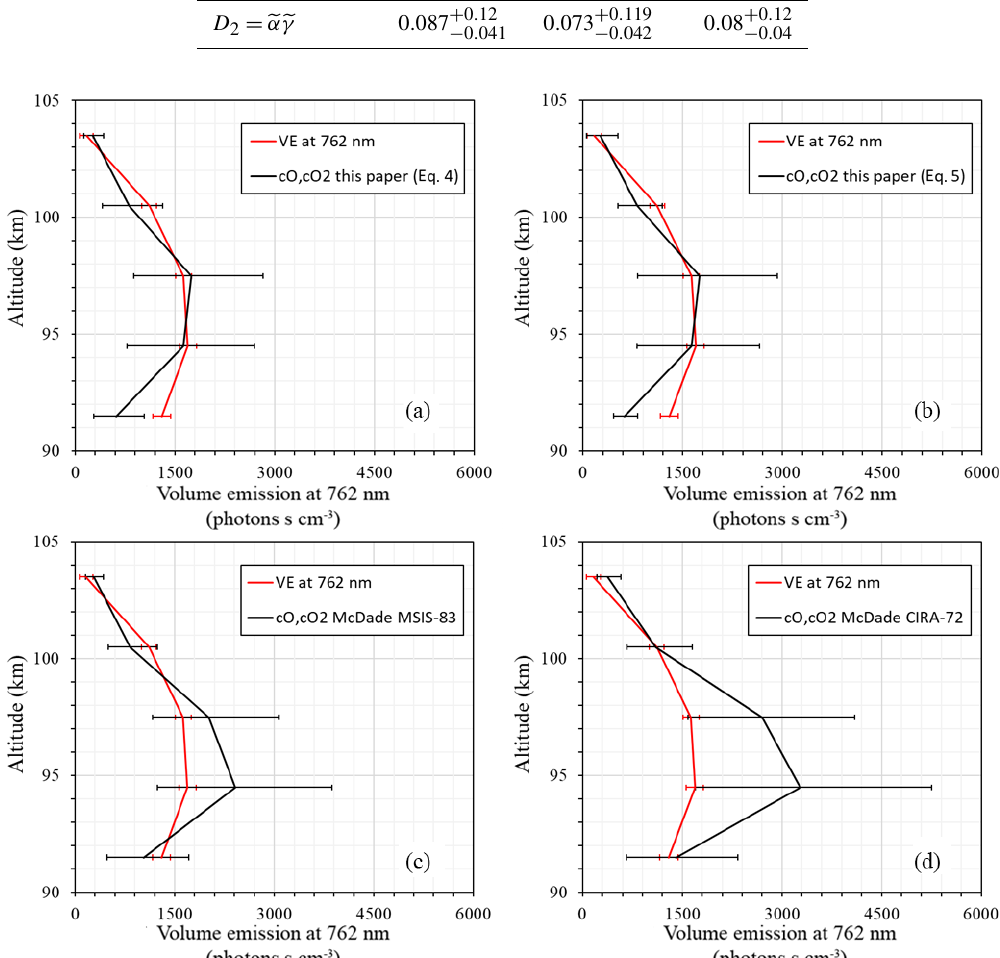
Figure 5. Volume emissions: photometer (red line); derived from atomic oxygen (black line) with (a) newly derived fitting coefficients for the two-step mechanism, (b) with fitting coefficients for the combined mechanism, (c) with McDade et al. (1986) coefficients that correspond to MSIS-83 temperature, and (d) with McDade et al. (1986) coefficients that correspond to CIRA-72